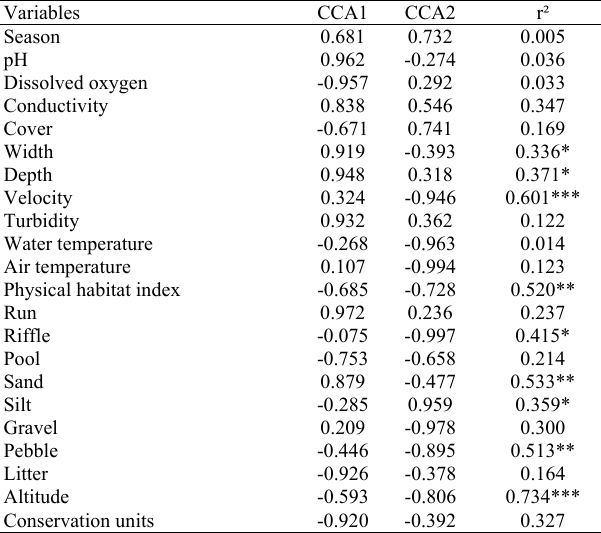
Table 5. Results of Canonical Correspondence Analysis (canonical coefficients [CCA1 and CCA2] and squared correlation coefficients [r 2 ]), of fish assemblages and environmental variables in streams of the APA Gama and